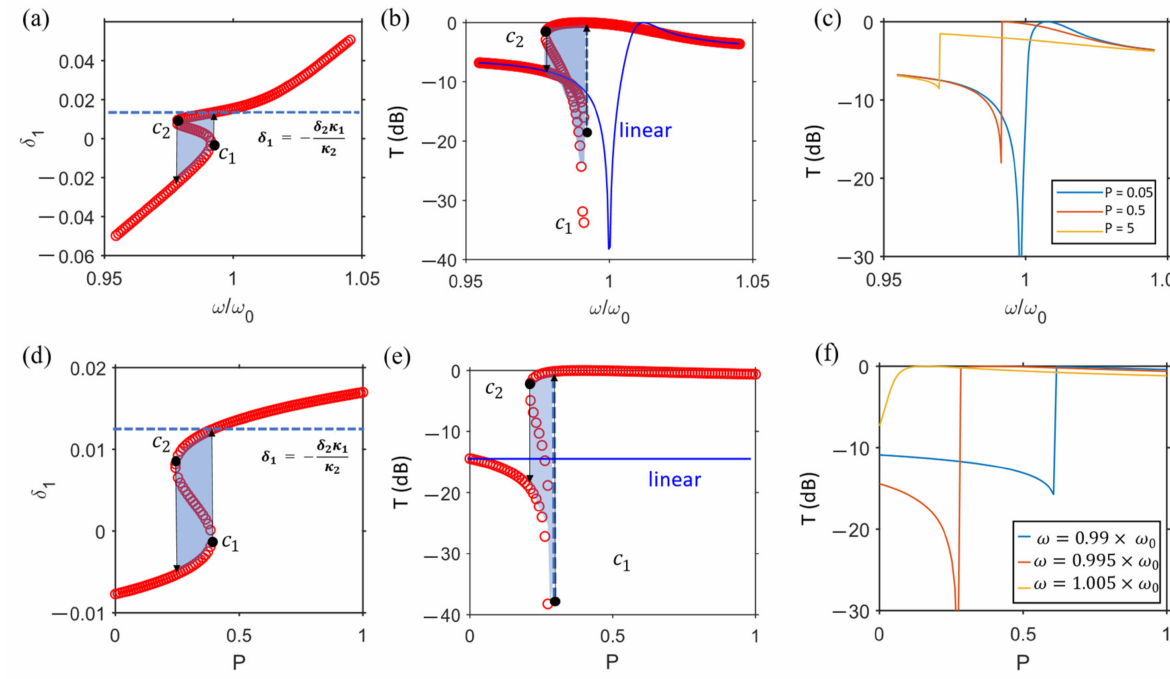
Figure 2. Nonlinear response of individual Fano resonators as a function of the input frequency and power. ( a ) Bistability in the shift of the zero-transmission frequency, δ 1 , versus the frequency ω of the input plane wave, with fixed input power P = 0.5. For an incident wave with an increasing frequency, the shift follows the path through the point c 1 along the arrow direction to the top branch, and for a decreasing frequency the shift path follows the line passing through the point c 2 along the arrow direction to the lower branch. The dashed lines indicate the value δ 1 , such that the transmission coefficient goes to 0 dB. ( b ) Similar to ( a ), but with the transmission coefficient instead of shift δ 1 . The blue line plots the linear response of the resonator, i.e., at P = 0. ( c ) Similar to ( b ) but considering different power levels and only branches with an increasing frequency. ( d – f ) Similar to ( a – c ) but analyzing the variations with the input power at fixed frequency ω = 0.995 × ω 0 . The other parameters are constant for all of the subfigures, ω 0 = 1.1, κ 2 = 152, ω 2 = 100, and κ 1 =